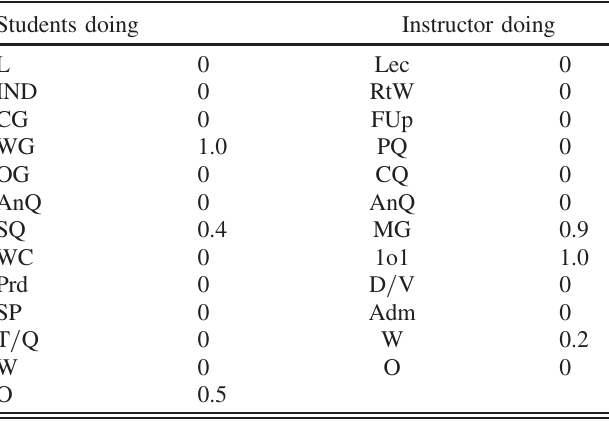
TABLE IV. COPUS profile example. The total number of occurrences for each code was tallied in each column, and divided by the number of intervals. For this example, there were 10 intervals.